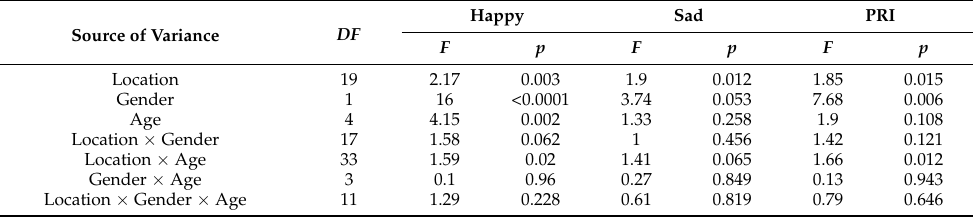
Table 2. Analysis of variance (ANOVA) of main effects and interactions among wetland park locations, and gender and age of visitors, on happy, sad, and positive response index (PRI)